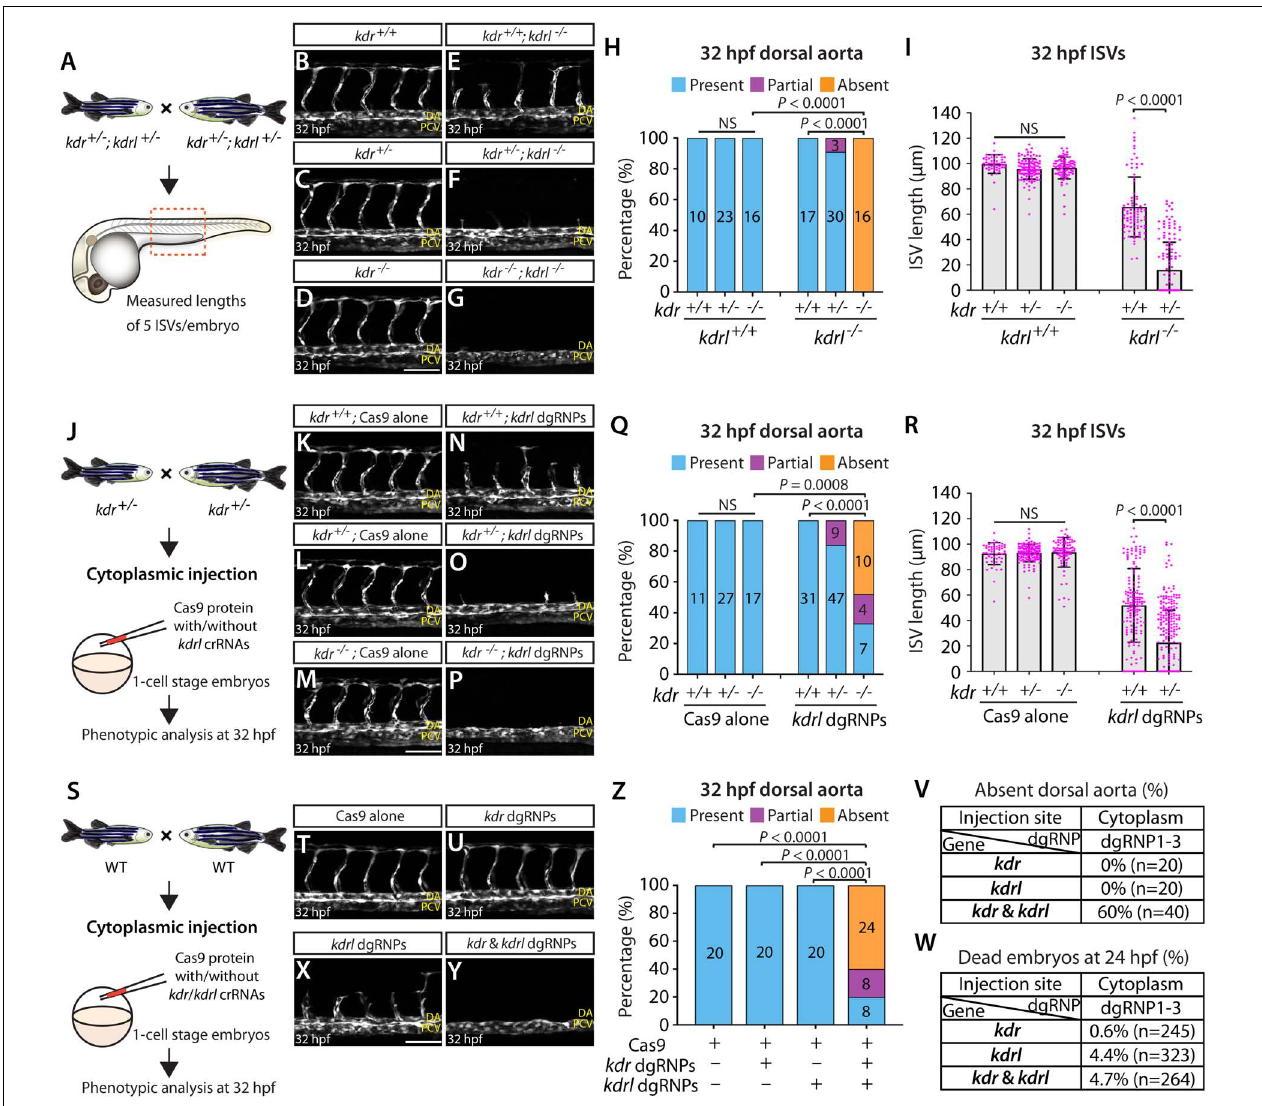
FIGURE 8 | Simultaneous disruptions of the Vegfr2 zebrafish paralog genes using a triple dgRNP injection method. (A) Experimental workflow of the phenotypic analysis presented in panels (B–I) . Adult kdr + / − ;kdrl + / − fish carrying the Tg(kdrl:EGFP) transgene were incrossed, and progeny generated from the crosses were imaged to quantify the formation of the dorsal aorta and aISVs at 32 hpf. (B–G) Lateral views of kdr + / + (B) , kdr + / − (C) , kdr − / − (D) , kdr + / + ;kdrl − / − (E) , kdr + / − ;kdrl − / − (F) , and kdr − / − ;kdrl − / − (G) trunk vasculature visualized by Tg(kdrl: EGFP ) expression at 32 hpf. No obvious trunk vascular defects were observed in kdr + / + , kdr + / − , and kdr − / − embryos (B–D) . kdr + / + ;kdrl − / − embryos exhibited stalled aISV growth (E) , and this aISV growth defect was exacerbated in kdr + / − ;kdrl − / − embryos (F) . In all kdr − / − ;kdrl − / − embryos examined at 32 hpf, the dorsal aorta failed to form (G) . DA: dorsal aorta; PCV: posterior cardinal vein. (H) Percentage of 32 hpf embryos of indicated genotype exhibiting the presence, partial presence, and absence of the dorsal aorta (the number of the animals examined per genotype is listed in the panel). (I) Quantification of aISV lengths of 32 hpf embryos of the indicated genotypes ( n = 10 for kdr + / + , n = 23 for kdr + / − , n = 16 for kdr − / − , n = 17 for kdr + / + ;kdrl − / − , and n = 30 for kdr + / − ;kdrl − / − ; 5 aISV lengths measured per embryo). kdr + / − ;kdrl − / − embryos displayed significantly shorter average aISV lengths than those of kdr + / + ;kdrl − / − embryos. (J) Experimental workflow of the microinjection experiments for panels (K–R) . Injection cocktails containing Cas9 protein with and without the three kdrl crRNA:tracrRNA duplexes were injected into the cytoplasm of one-cell stage embryos generated from incrosses of kdr + / − fish carrying the Tg(kdrl:EGFP) transgene. Injected progeny were imaged to quantify the formation of the dorsal aorta and aISVs at 32 hpf. (K–P) Lateral trunk views of the 32 hpf kdr + / + (K,N) , kdr + / − (L,O) , and kdr − / − (M,P) embryos injected with Cas9 protein with (N–P) or without (K–M) the three kdrl crRNA:tracrRNA duplexes ( kdrl dgRNPs). Trunk vasculature was visualized by Tg(kdrl: EGFP ) expression. No obvious trunk vascular defects were observed in kdr + / + , kdr + / − , and kdr − / − embryos injected with Cas9 (K–M) . In contrast, kdr + / + embryos injected with the triple kdrl dgRNPs displayed the stalled aISV phenotype (N) . Exacerbated aISV defects were observed in the kdrl dgRNPs-injected kdr + / − embryos (O) . A nearly half of the kdrl dgRNPs-injected kdr − / − embryos exhibited a complete absence of the dorsal aorta (P) . (Q) Percentage of 32 hpf embryos of the indicated genotype and treatment exhibiting the presence, partial presence, and absence of the dorsal aorta (the number of the animals examined per group is listed in the panel). (R) Quantification of aISV lengths of 32 hpf embryos of the indicated genotype and treatment ( n = 11 for Cas9-injected kdr + / + , n = 27 for Cas9-injected kdr + / − , n = 17 for Cas9-injected kdr − / − , n = 31 for kdrl dgRNPs-injected kdr + / + , and n = 47 for kdrl dgRNPs-injected kdr + / − ; 5 aISV lengths per embryo measured). kdr + / − embryos injected with the kdrl dgRNPs